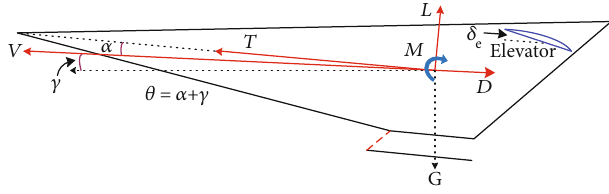
Figure 1: Geometry and force map of HFV